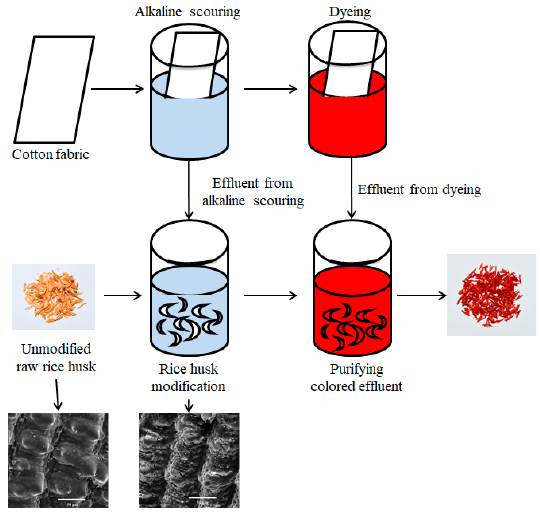
Figure 2. Schematic of rice husk modification and purifying colored effluent.